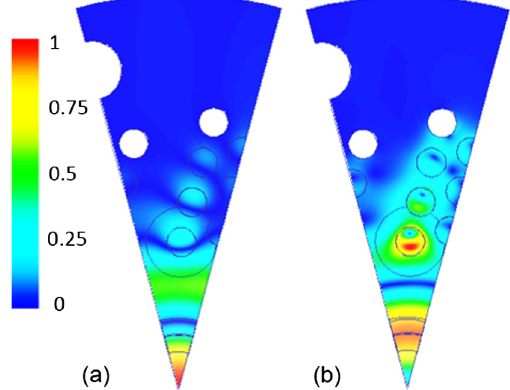
FIG. 9. The normalized field map of (a) the electric field, and (b) the magnetic field of the central plane of the HPBG-d3 structure in simulation. White circles indicate the copper rods, which exclude the fields. The sapphire rod locations are more easily seen in Fig. 10.